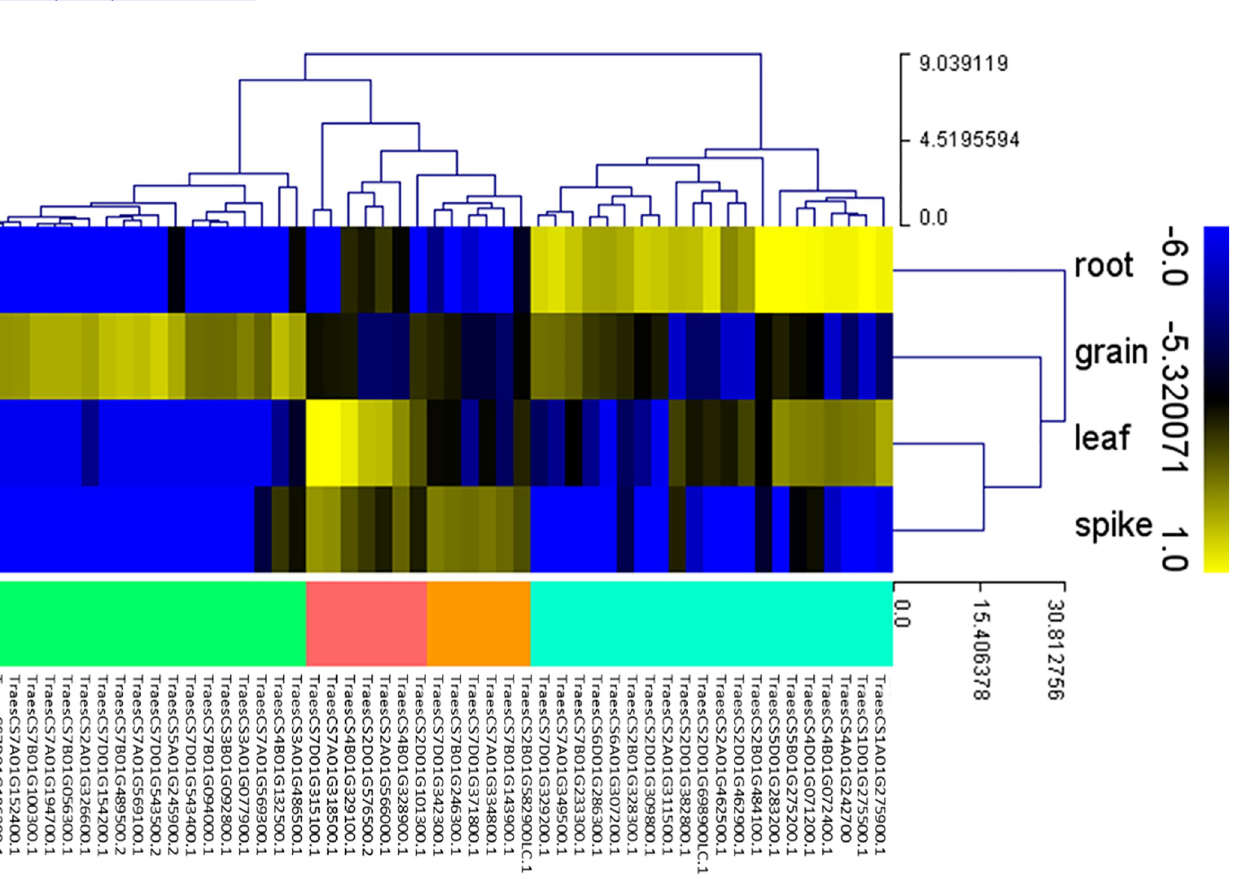
Fig 6. Heat map of 52 TaNAC genes expression profile in four organs (grain, spike, leaf, and root), using the RNAseq data of Choulet et al . [55]. These 52 TaNAC genes have a highly preferred expression pattern distributed as follows: 19 in the grain (green branches), 7 in the leaf (red branches), 20 in the root (blue branches), and 6 in the spike (orange branches). This figure was generated using MeV software. Hierarchical clustering was performed for the transcript abundance from all